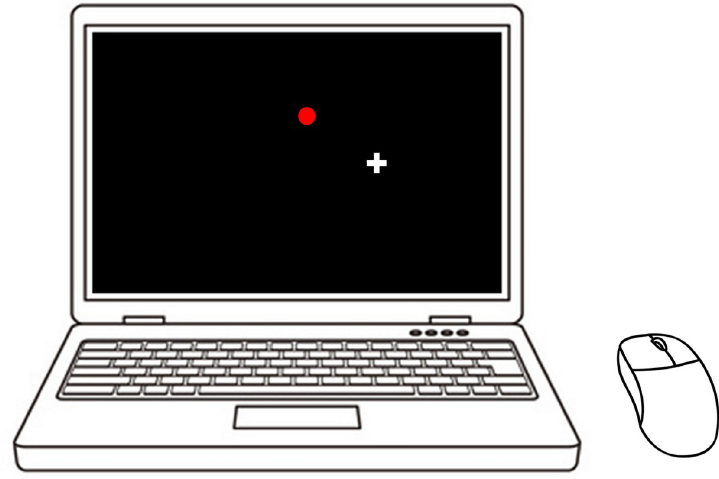
Fig 1. Experimental apparatus. The participants sat on a height-adjustable chair in front of a desk and performed a tracking task. All the participants used the same computer mouse and laptop computer (Dell, Inspiron 13” screen) placed 60 cm in front of